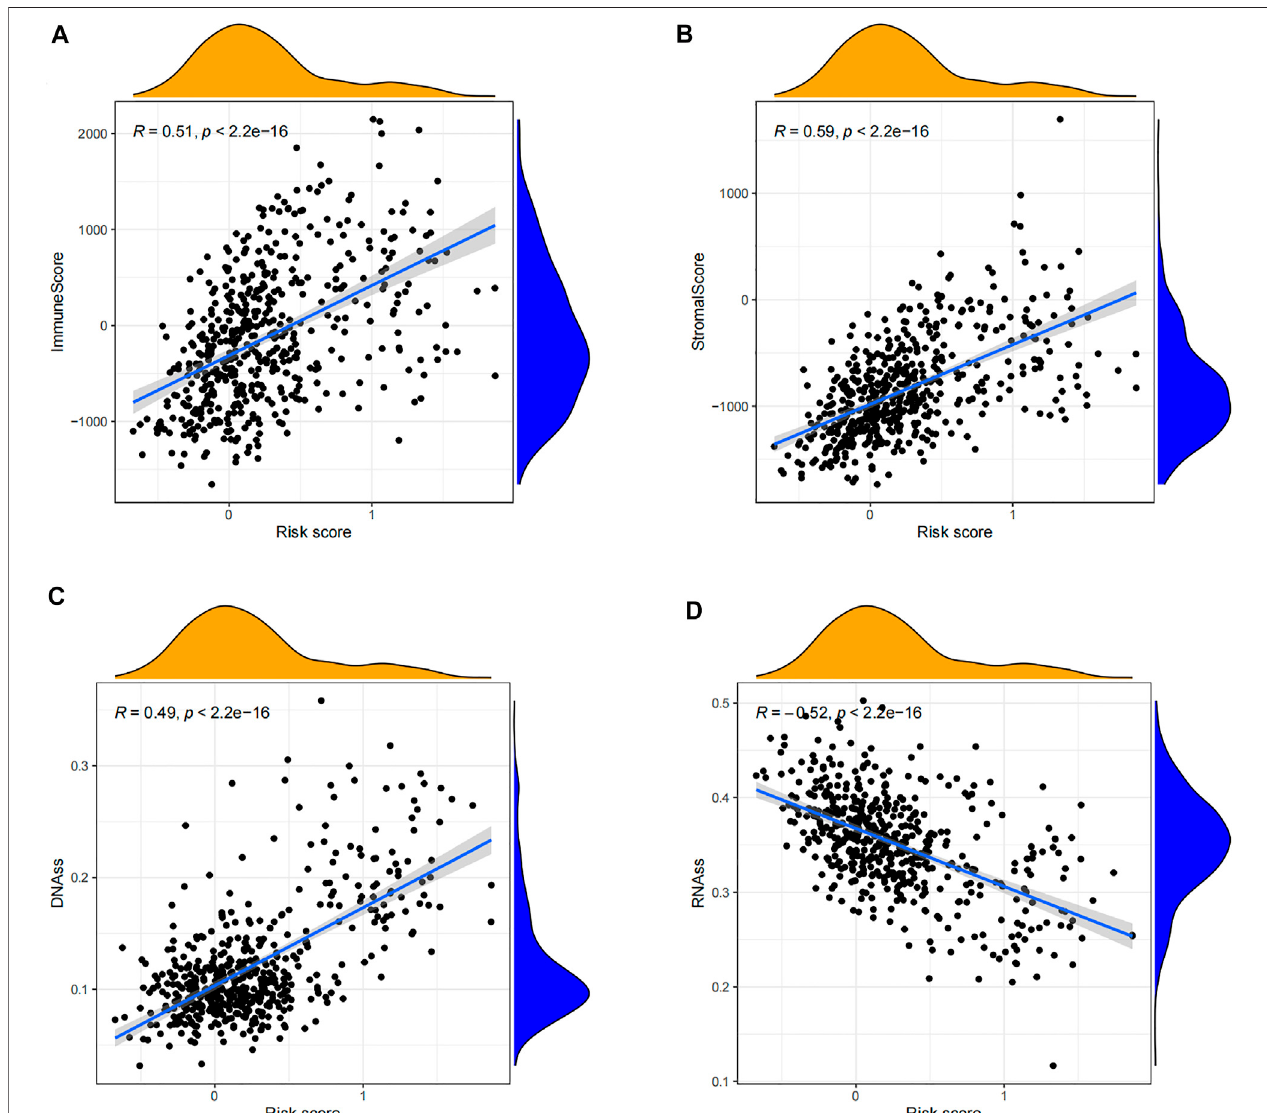
FIGURE 6 | Correlation analysis of tumor microenvironment and stem cells. (A) Scatterplot of correlation between the immune cell score and risk score of LGG patients. (B) Scatterplot of correlation between the stromal cell score and risk score in LGG patients. (C) Scatterplot of the association between the stem cell score (DNAss) and risk score for LGG patients. (D) Scatterplot of the association between the stem cell score (RNAss) and risk score for LGG patients.